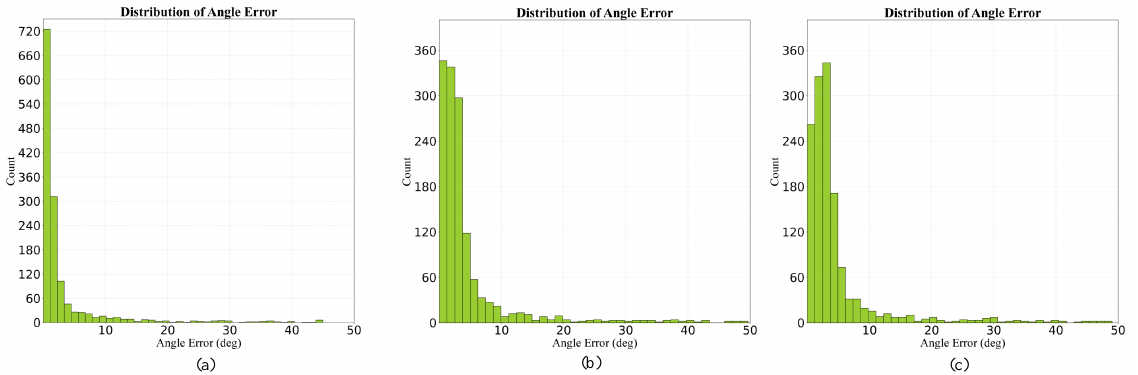
Figure 6. Error distribution of three methods in the aspect of orientation at dataset 19. ( a ) shows the estimation result of our PE-HL-PF, ( b ) denotes the result of PE-CPD, and ( c ) shows the result of PE-CHM.